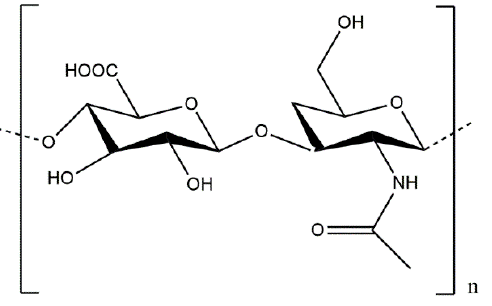
Figure 16. Schematic representation of the chemical structure of